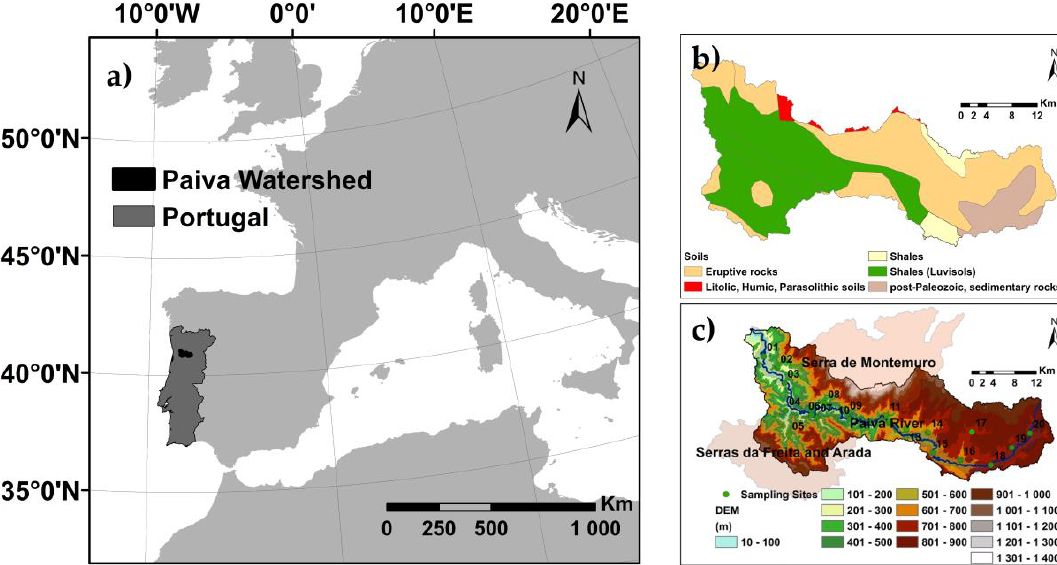
Figure 1. The Paiva River catchment: ( a ) geographical location in southwestern Europe and Portugal; ( b ) soil types (cf. legend for details on classes); and, ( c ) hypsometric chart showing the selected Digital Elevation Model, DEM (elevation in meters).